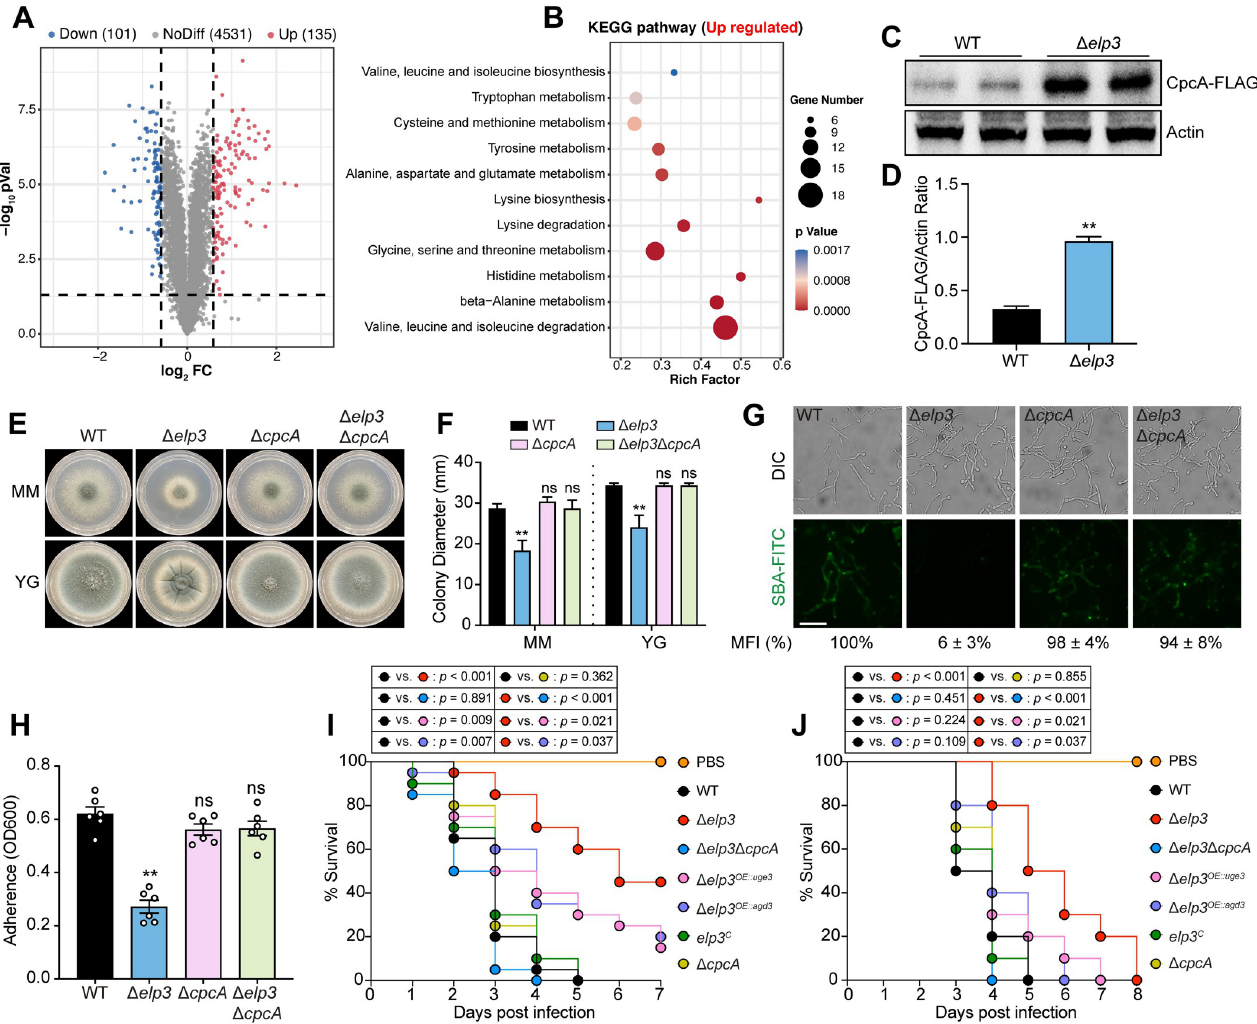
Fig 7. Deletion of CpcA restored the defects of the Δ elp3 mutant, including reduced hyphal growth, GAG production, adhesion and virulence. (A) Volcano plot showing the fold change and statistical significance of the differences in quantitative protein expression between the wild-type and Δ elp3 strains grown at 37˚C for 24 h. (B) KEGG pathway enrichment analysis of upregulated proteins in the Δ elp3 mutant strain compared to the wild-type strain. (C) Western blots of the protein expression of CpcA in the wild-type and Δ elp3 strains. β -actin served as a loading control. (D) Quantified western blot signal intensity of CpcA-FLAG relative to actin in the indicated strains. The data are presented as the mean ± SEM (standard error of the mean) of three independent experiments. Statistical analysis was performed using one-tailed, unpaired t tests. �� p < 0.01. (E) Morphologies of the colonies formed by wild-type, Δ elp3 , Δ cpcA and Δ elp3 Δ cpcA double mutants grown on solid minimum medium (MM) and complete YG medium at 37˚C for 48 h. (F) Quantitative analysis of the diameters of the colonies formed by the indicated strains grown at 37˚C for 48 h on solid minimum medium (MM) and complete YG medium. The data are presented as the mean ± SEM (standard error of the mean) of three independent experiments. Statistical analysis was performed using one-way ANOVA with multiple comparisons tests. �� p < 0.01; ns, not significant. (G) GAG production of the indicated strains was visualized by soybean agglutinin (SBA) lectin staining. Scale bar = 10 μ m. The mean fluorescence intensity (MFI) of SBA-FITC in the indicated strains was calculated and normalized to the wild-type (100%). (H) Quantification of adhesion ability by the indicated strains by crystal violet staining. The data are presented as the mean ± SEM (standard error of the mean) of three independent experiments. Statistical analysis was performed using one-tailed, unpaired t tests. �� p < 0.01; ns, not significant. (I and J) Survival curves of G . mellonella larvae (I) and mice (J) infected with the indicated strains. PBS-injected larvae and mice were used as negative controls. Statistical differences between groups were determined using a log-rank